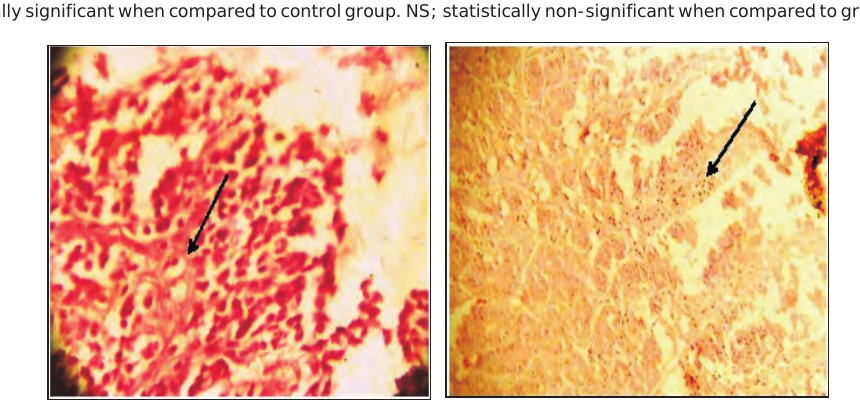
Figure-2. Photograph showing intact villi and reduced haemorrghage in intestine of rats of group-II (H&E X